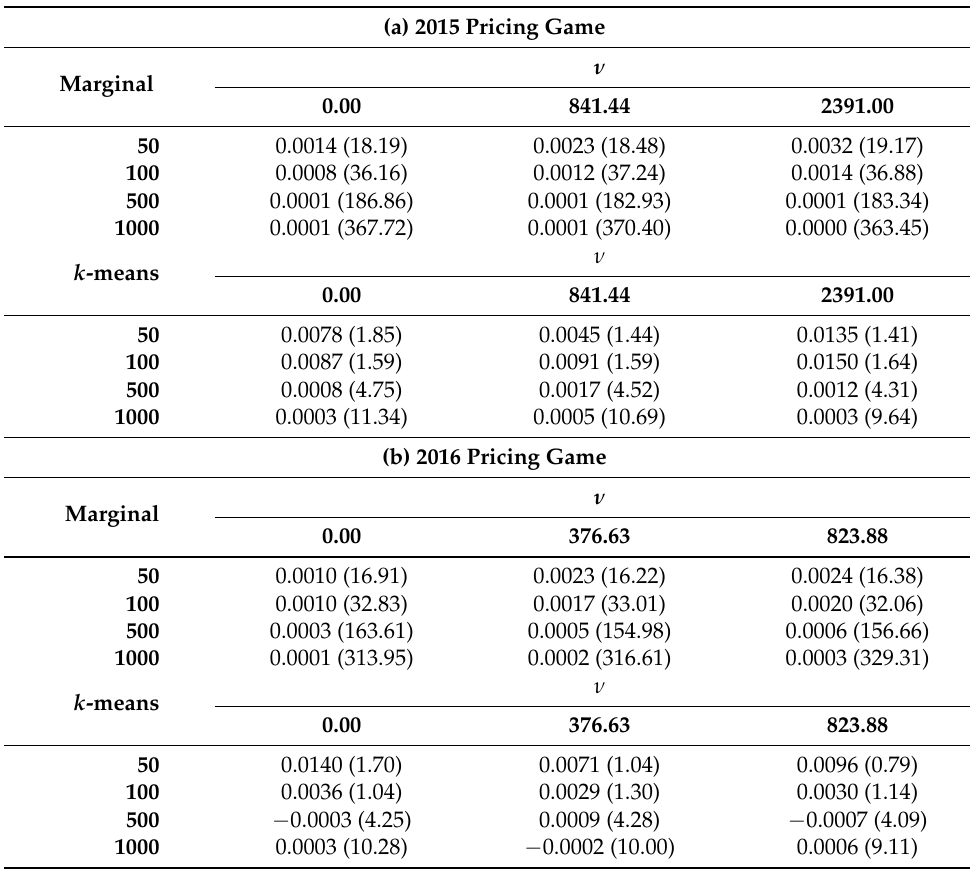
Table 10. The bias and run time (s), the latter between brackets, for the marginal approximation and the k -means approximation of the concordance probability, both for the dataset of the 2015 (a) and 2016 (b) pricing game their severity